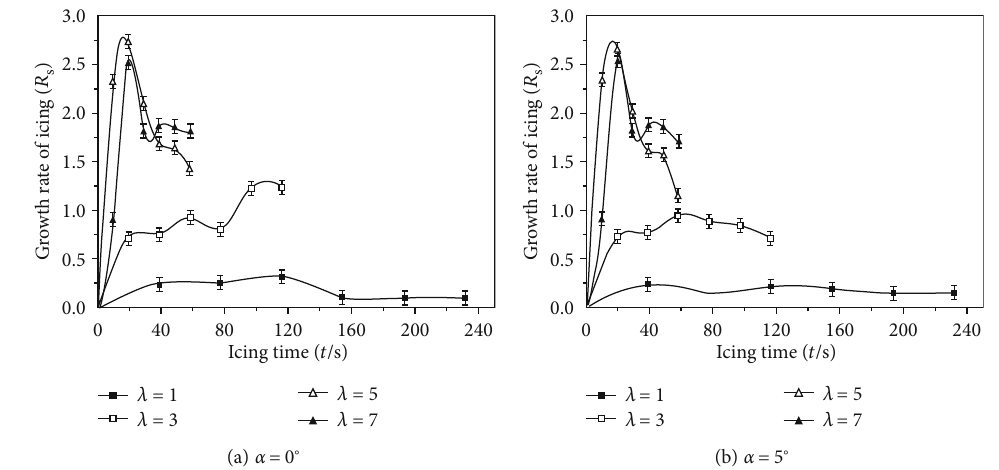
Figure 21: Growth rate of icing under di ff erent tip speed ratios.